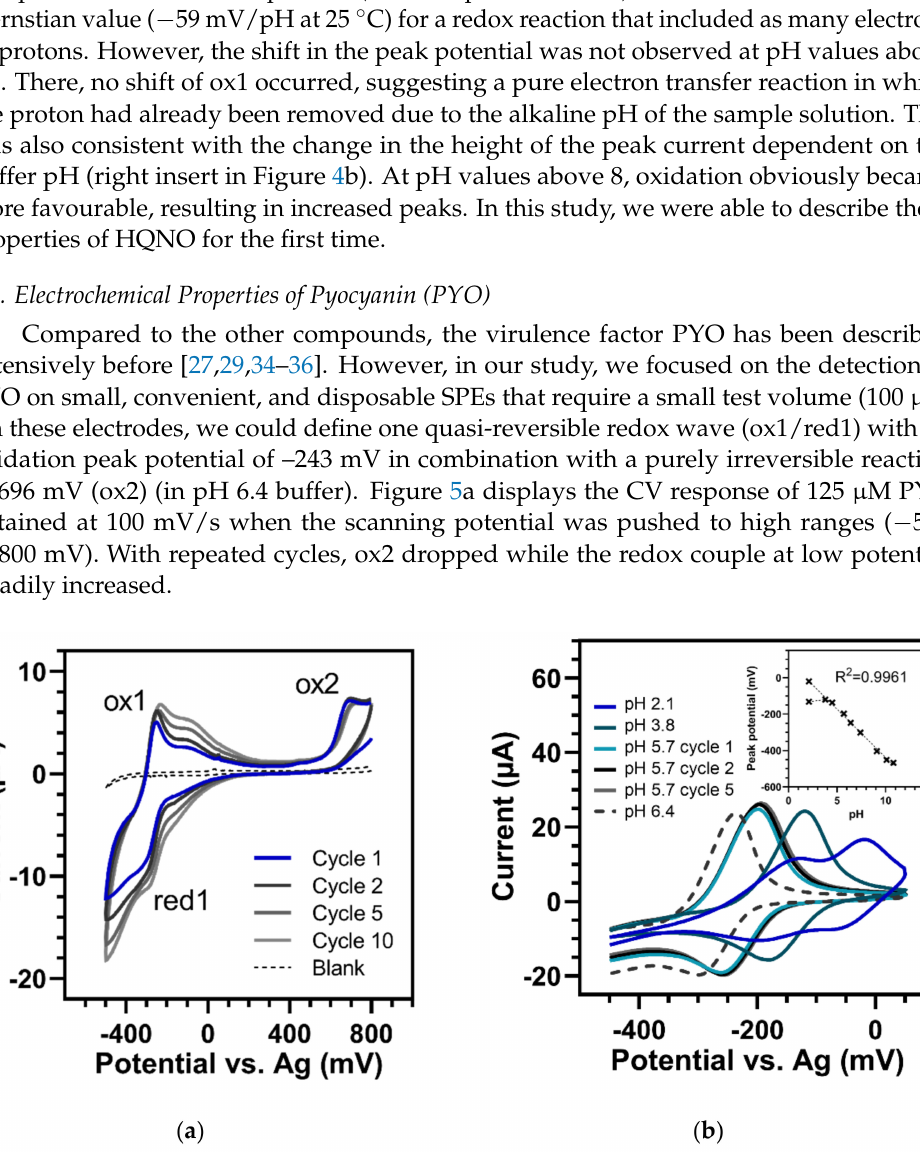
Figure 5. Cyclic voltammetry of PYO (100 mV/s). ( a ) First ten cycles of 125 µ M PYO in buffer of pH 6.4 (potential range –500 to 800 mV). After the first cycle (blue), ox2 dropped, while the redox couple (ox1/red1) continuously increased (black to light grey). Blank = pH 6.4 buffer. ( b ) Dependency of 250 µ M PYO on buffer pH. Insert: Linear regression of oxidation peak potentials according to pH (pH 2.1 to 10.8). Error bars represent the standard deviations of three